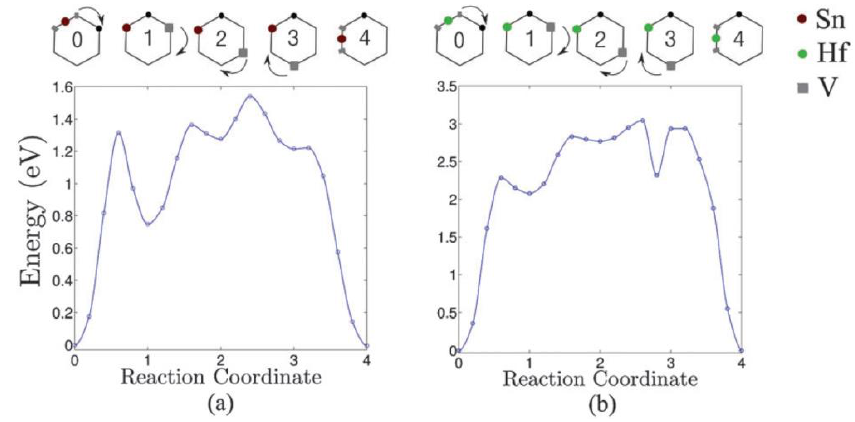
Figure 4. Diffusion of the PV in the presence of ( a ) Sn and ( b ) Hf significantly increases the migration energy barrier. Reproduced by permission from the PCCP Owner Societies [54].